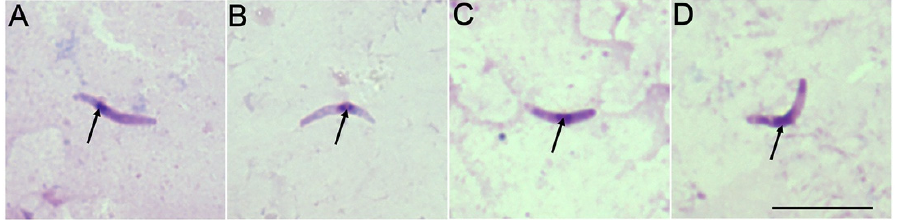
Figure 2. Sporozoites of Haemoproteus majoris ( A ) and Haemoproteus tartakovskyi ( B ) in salivary gland preparations of Culicoides segnis , and sporozoites of Haemoproteus parabelopolskyi ( C ) and Haemoproteus sp. ( D ) in salivary gland preparations of Culicoides pictipennis . Arrows indicate nuclei of the parasites. Scale-bar: 10 µ m. Table 2. Morphometric parameters of sporozoites of three Haemoproteus = 0.02) and H. parabeloposkyi (t = 4.99, p = 0.00), while the sporozoite width did not differ between different parasite species ( p > 0.05).